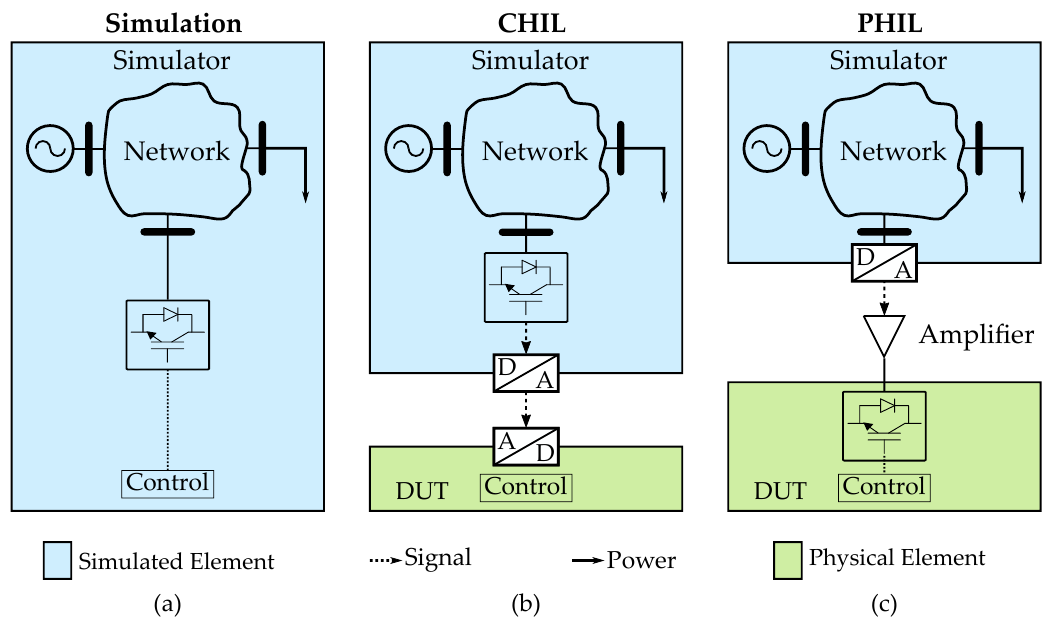
Figure 1. Possible testing setups for assessing the effect of a new smart grid technology in the power system: ( a ) Simulation, ( b ) Control Hardware-in-the-Loop (CHIL), ( c ) Power-Hardware-in-the-Loop